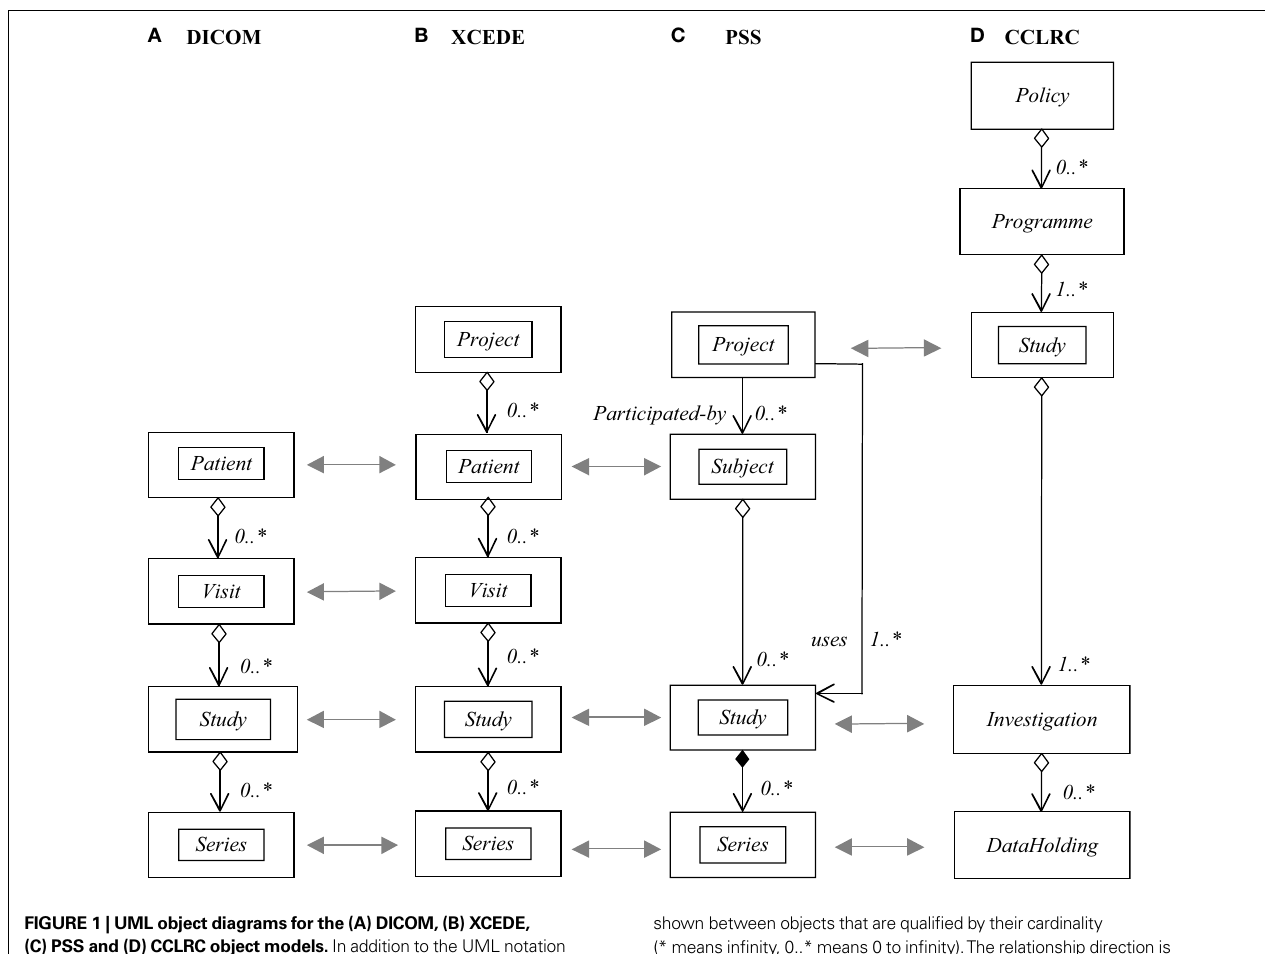
shown between objects that are qualifi ed by their cardinality (* means infi nity, 0..* means 0 to infi nity). The relationship direction is indicated via an arrow. Filled diamonds indicate that the relationship is containment (also called composition) and open diamonds indicate an aggregation (has)